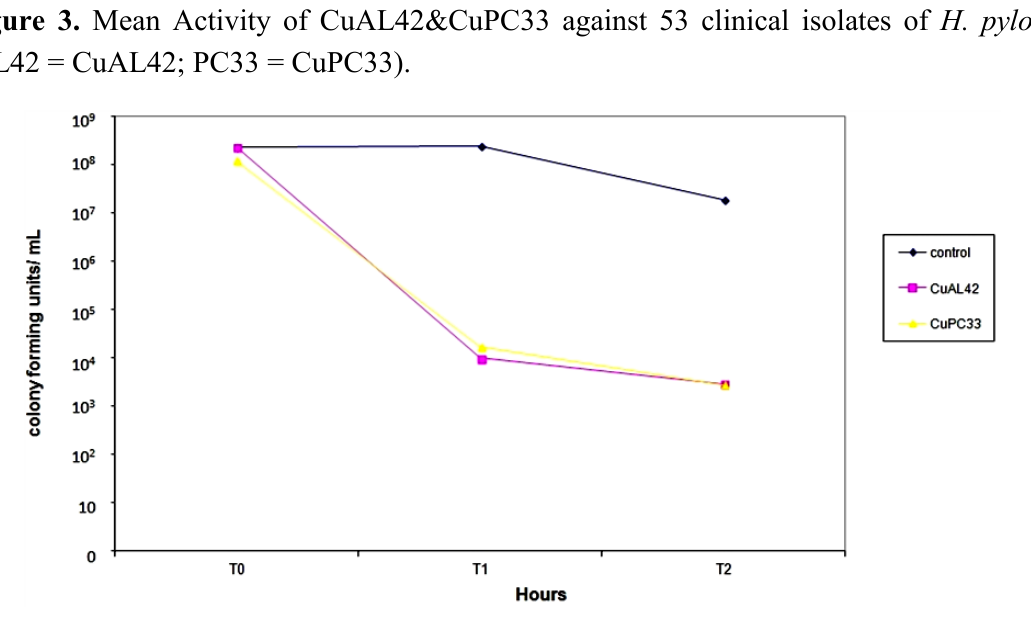
Figure 4. Number of H. pylori isolates killed at one hour (T1) and two hours (T2) by CuAL42 and CuPC33 (PC33 = CuPC33; AL42 =